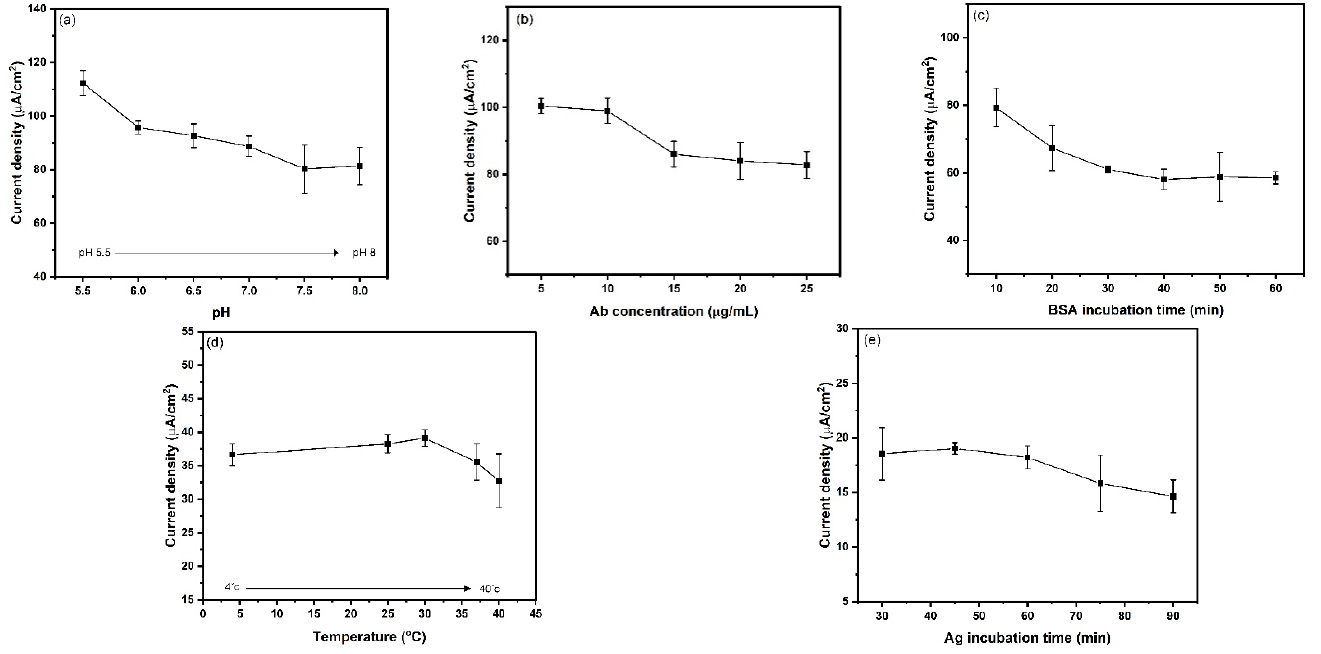
Figure 6. The effect of a key factor on the immunosensor in 0.1 X PBS containing 5 mM [Fe(CN) ₆ ]³ − /[Fe(CN) ₆ ] ⁴⁻ /0.1 M KCl. ( a ) influence of pH (0.1 X PBS), ( b ) Ab concentration (5–25 µg/mL), ( c ) BSA incubation time, ( d ) the temperature effect, and ( e ) Ag incubation time. All measurements were repeated three times ( n = 3).